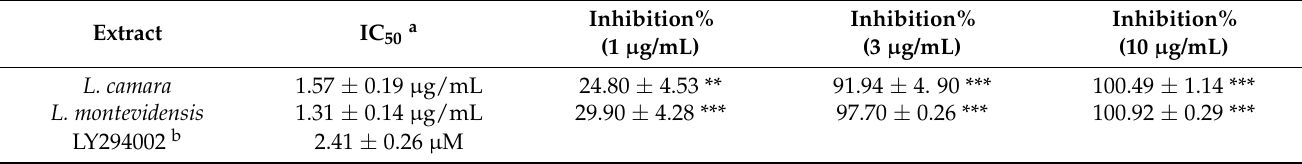
Effects of Lantana extracts on superoxide anion generation in fMLF/CB-induced human